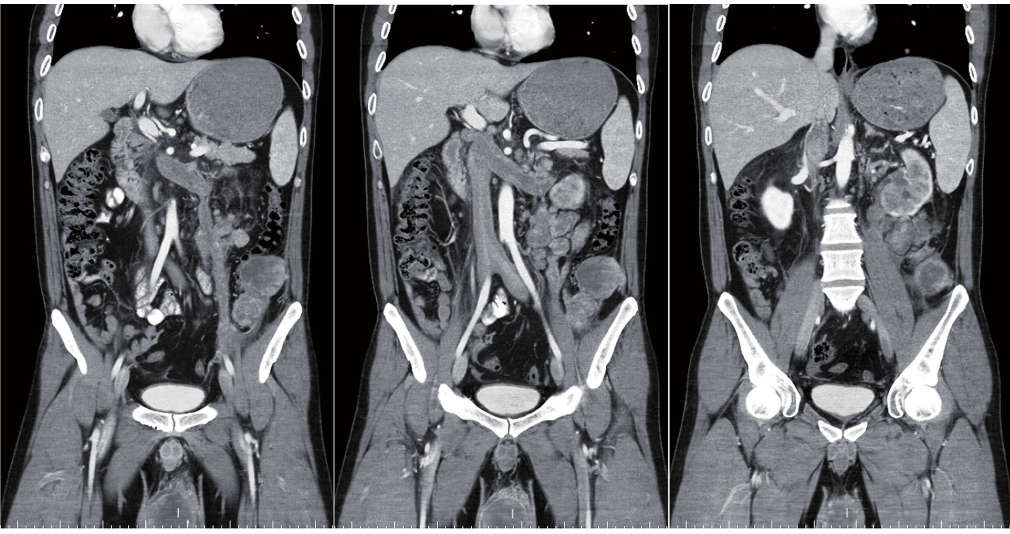
figure 1 - computerized tomography scan of the abdomen demonstrating the inferior vena cava thrombus extended from the left spermatic vein and bilateral external iliac veins to the hepatic vein, retroperitoneal multiple metastasis and the impairment of the left renal